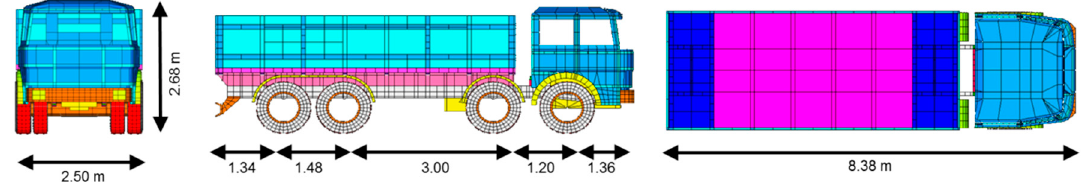
Figure 8. FE model of the 30-ton truck.